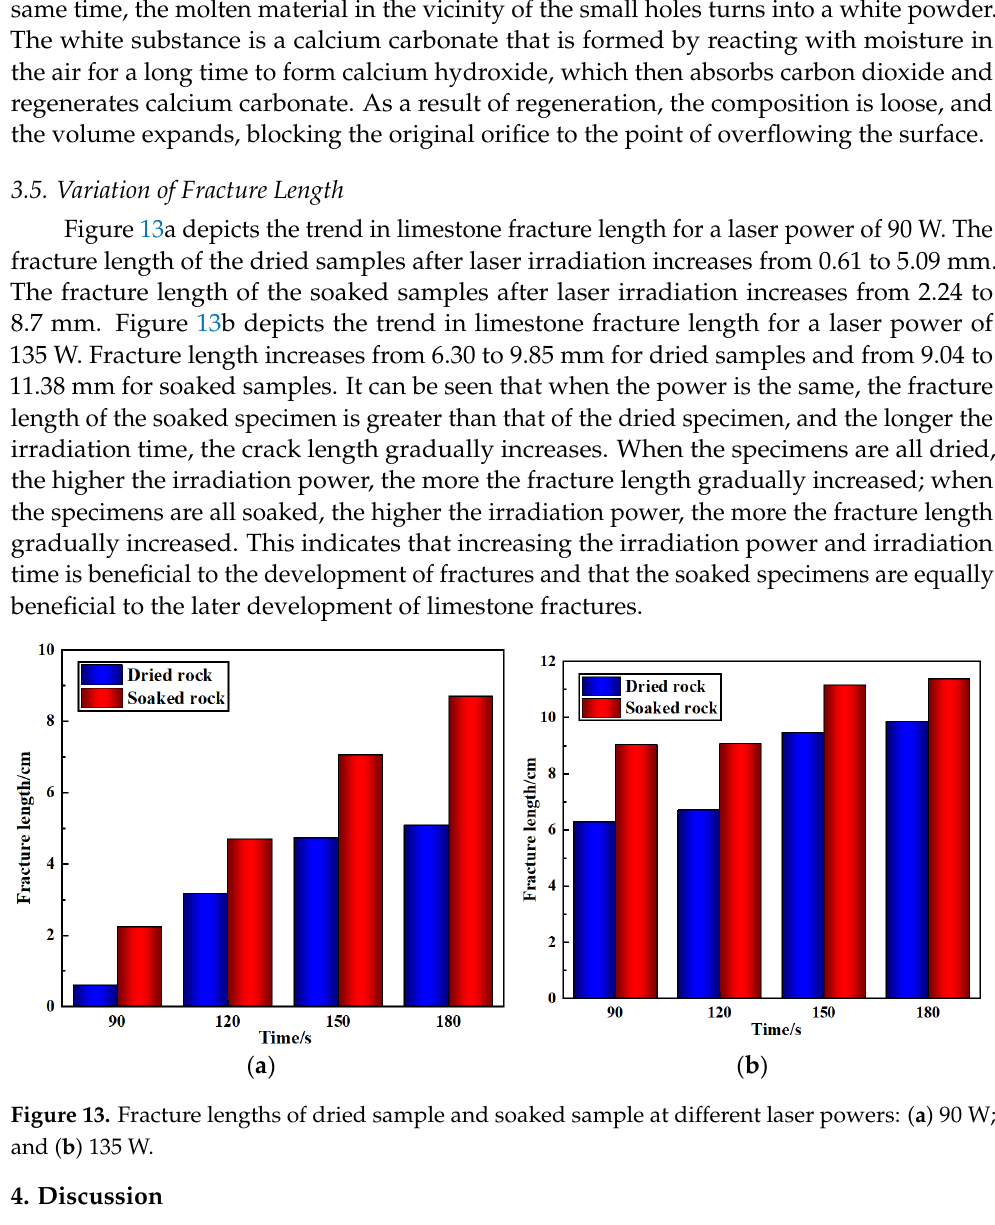
( b ) Figure 14. Plots of: ( a ) thermogravimetric curve; and ( b ) weight-loss rate with temperature. Figure 14b shows the variation in percentage weight loss concerning temperature. It was observed that the weight loss of the soaked samples first drops and reaches a point of inflection at 842 °C. At the same temperature, the weight loss of the dried sample is always smaller than that of the soaked sample, reaching the inflection point at 859 °C and reaching equilibrium later than that of the soaked sample. This is because the soaked rock contains more free water inside. In addition, after the rock is soaked, the bound water inside the mineral component will also increase, so the temperature at the inflection point is lower than that of the dry sample, and the minerals inside will first complete decompo- sition to reach the equilibrium position.